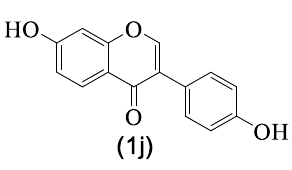
Figure 4. Daidzein 1j structure.